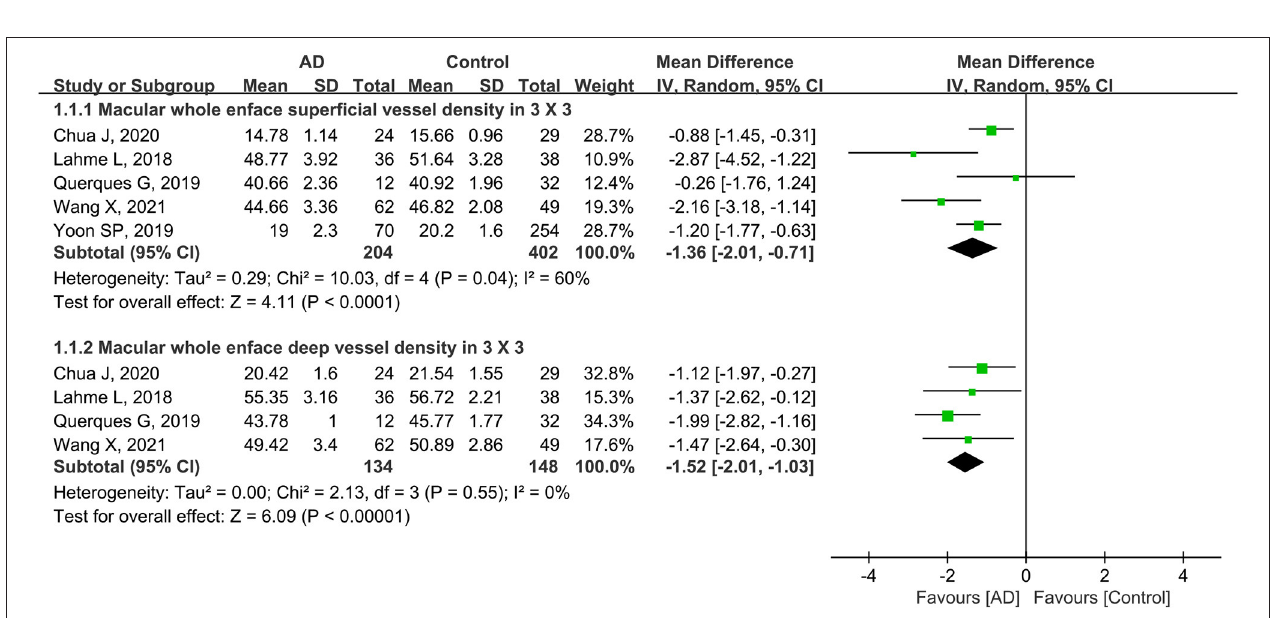
FIGURE 3 | Forest plot of macular whole enface superficial and deep vessel density using a 3 × 3-mm scan size in AD patients and controls.